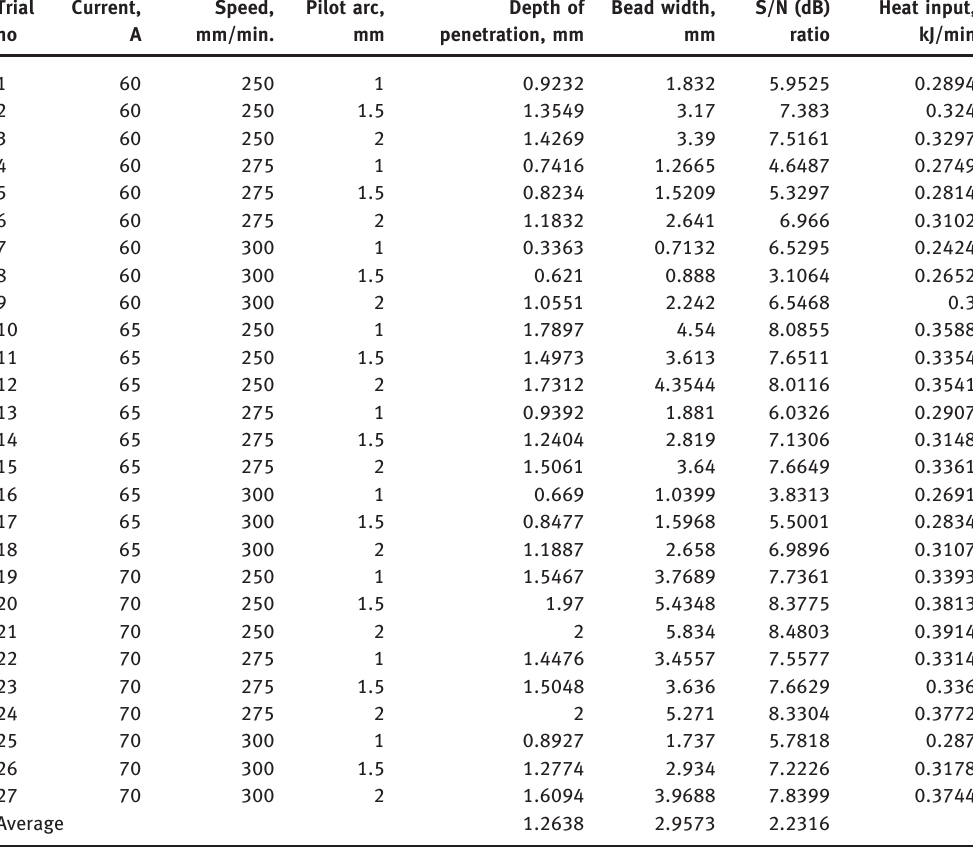
The strategy for conducting the bead-on plate welding trials and the subsequent ANOVA analysis are to study Table 4: Cumulative experimental data and the corresponding S/N ratio and the heat inputs. Trial no